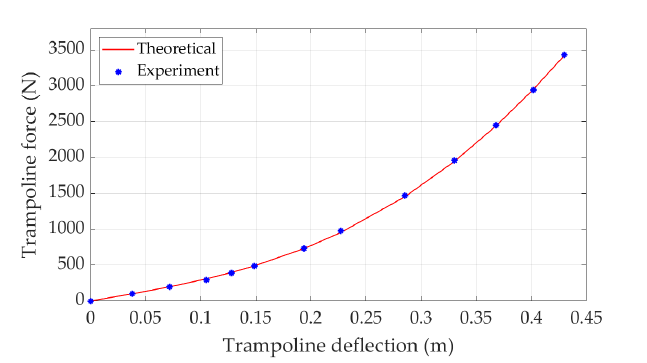
Figure 3. Trampoline static